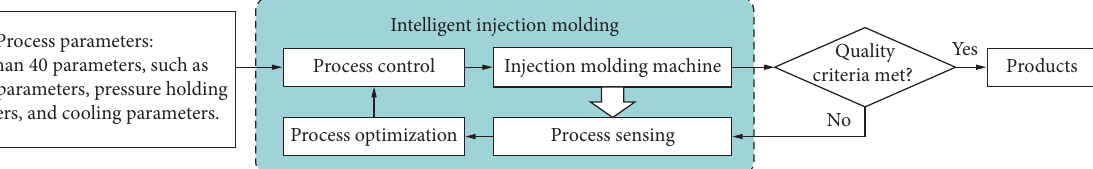
Figure 1: Schematic of an intelligent injection molding